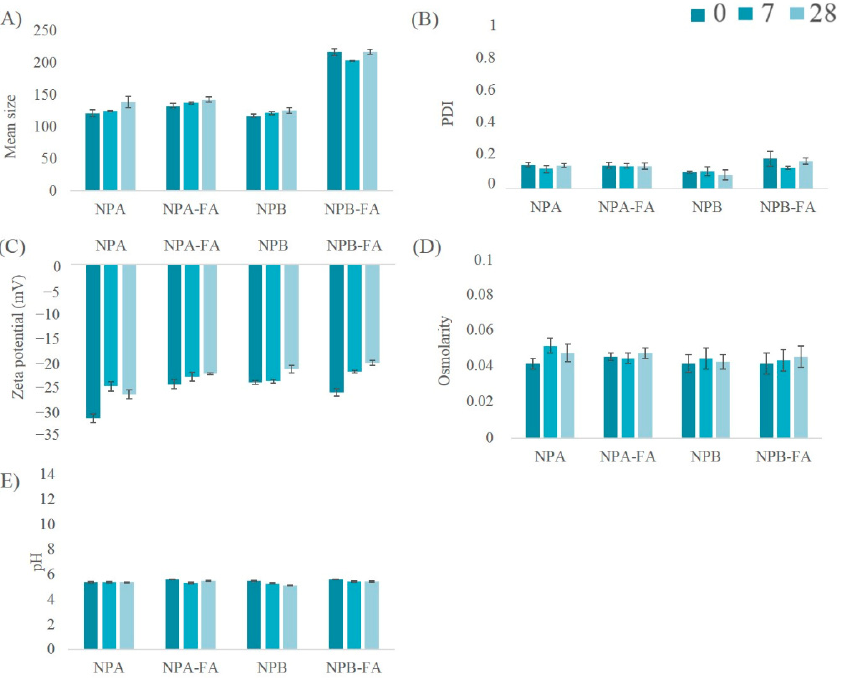
Figure 5. Mean size ( A ) index of polydispersion ( B ) zeta potential ( C ) osmolarity ( D ) and pH ( E ) of the samples stored at 5 °C.